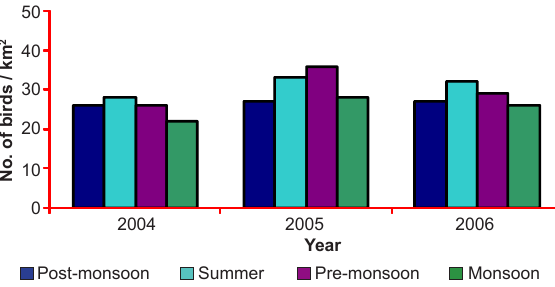
Figure 2. Habitat-wise variations in the density of the Indian Roller in river banks from 2004 to 2006